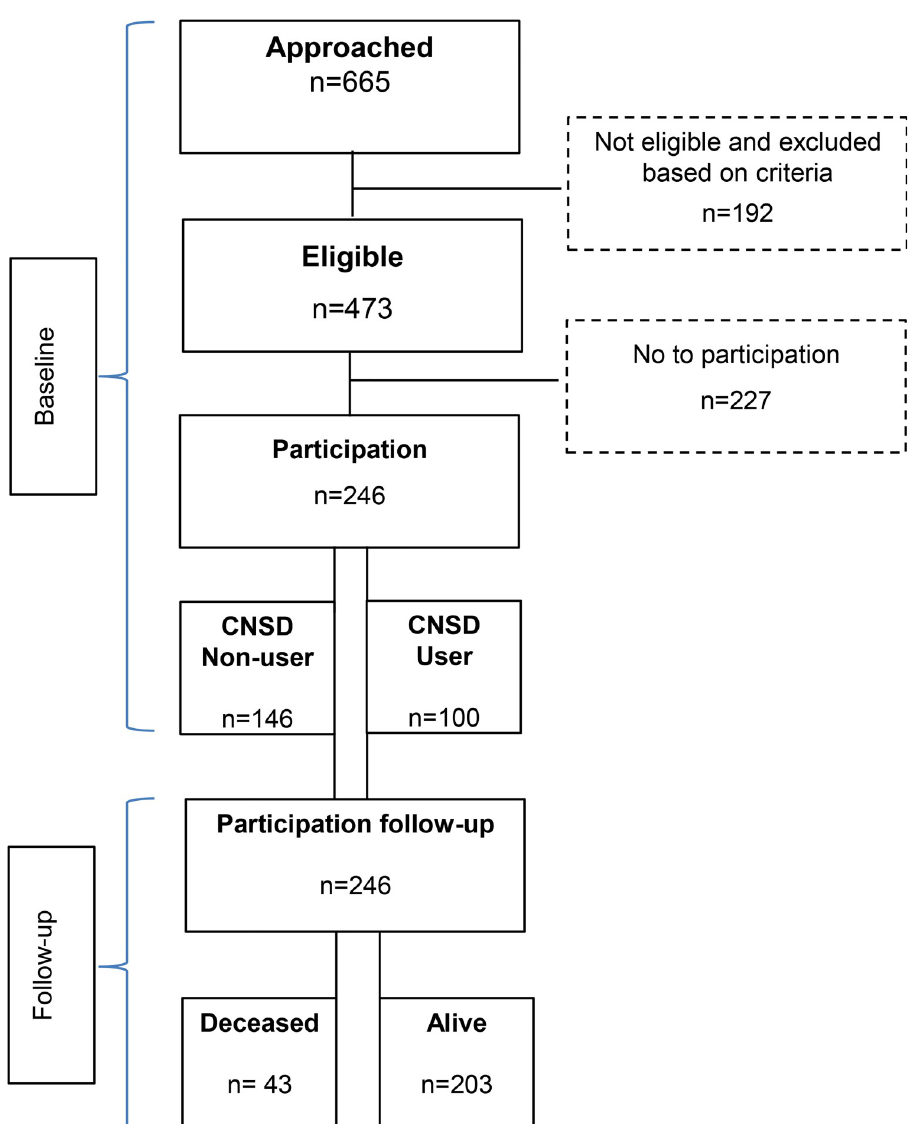
Fig 1. Flow chart of participation. Central nervous system